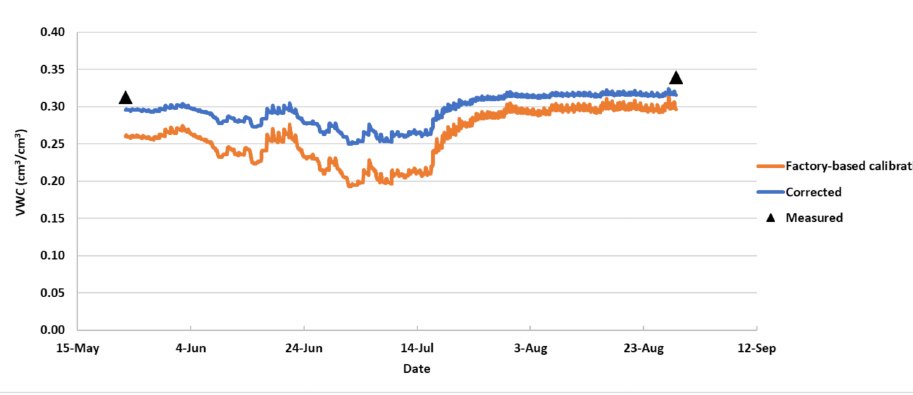
Figure 10. Comparison of factory-based calibration to corrected values for EC5 in sandy clay